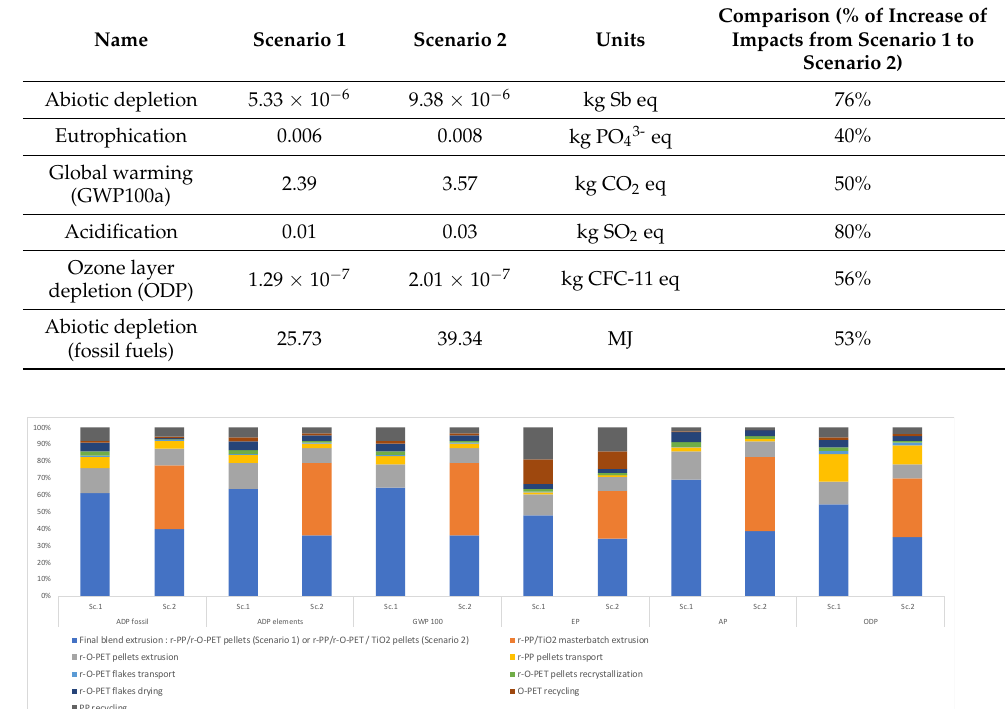
Table 5. Life Cycle Impact Assessment Results for both recycling scenarios using the CML method.